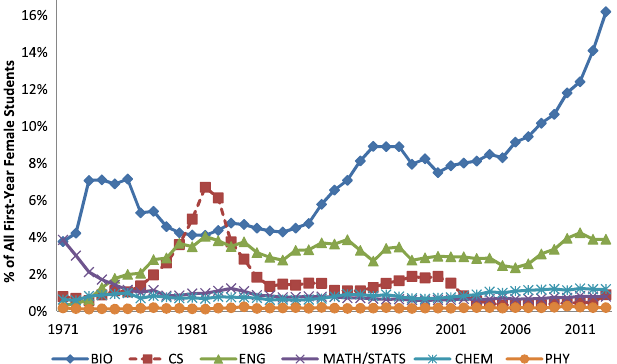
FIG. 2. The proportion of all first-year, female students who reported intention to major in a STEM fields from 1971 to